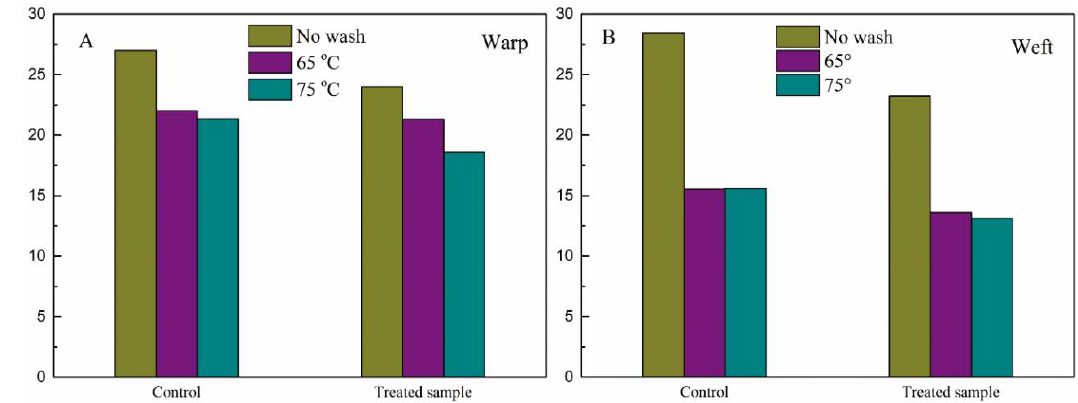
Figure 6. Tearing strength of control sample, scoured, coated, and washed samples (104 washing cycles, 65 o C with nonionic detergent but without bleaching agent); warp ( A ) and weft ( B ).